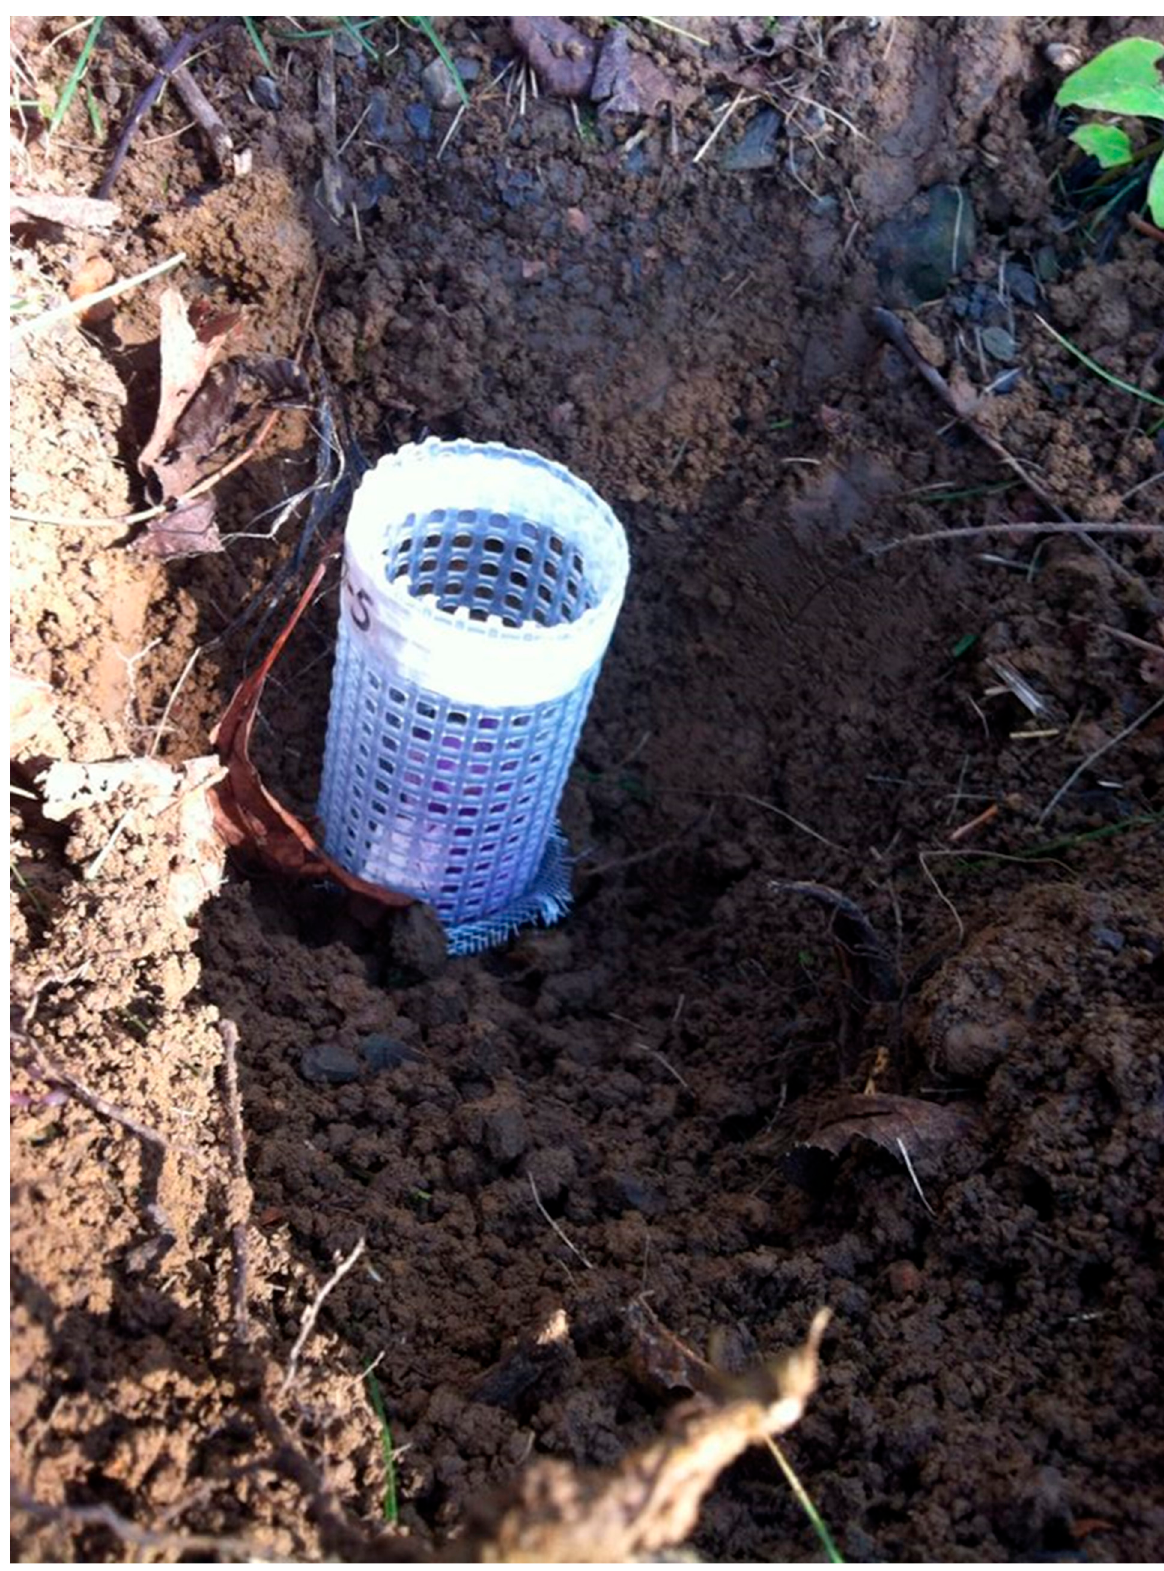
Figure A2. Depicted here is a burial site; cylindrical core was placed vertically into the burial site. The burial and cylindrical core was then filled in with native soil, and wood substrate was allowed to decompose.